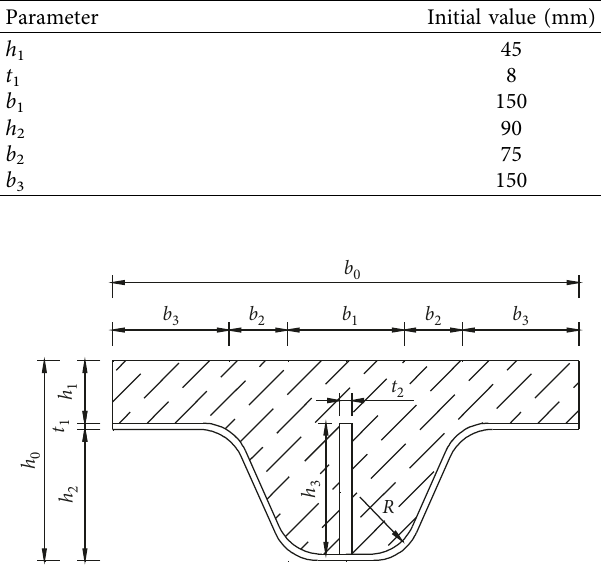
Figure 6: Cross section of corrugated steel plate-UHPC composite bridge deck.